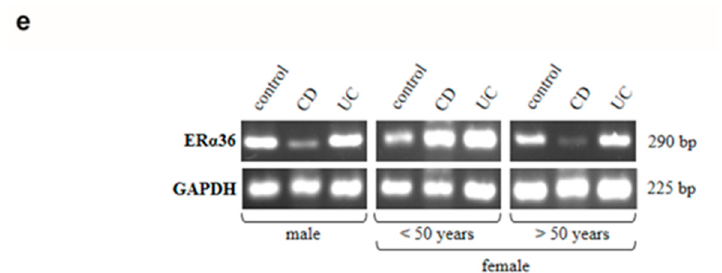
Figure 7. Expression of ER α 36 at mRNA level in CD and UC patients and the control group regardless of sex and age ( a ; control, n = 31; CD, n = 31; UC, n = 42), males with CD and UC ( b ; control, n = 12; CD, n = 19; UC, n = 24), females with CD an UC under the age of 50 years ( c ; control, n = 9; CD, n = 7; UC, n = 12), females with CD and UC over the age of 50 years and related controls ( d ; control, n = 10; CD, n = 5; UC, n = 6). Representative agarose gel image of ER α 36 expression ( e ). Values are means ± SEM; * P < 0.05 vs. control.